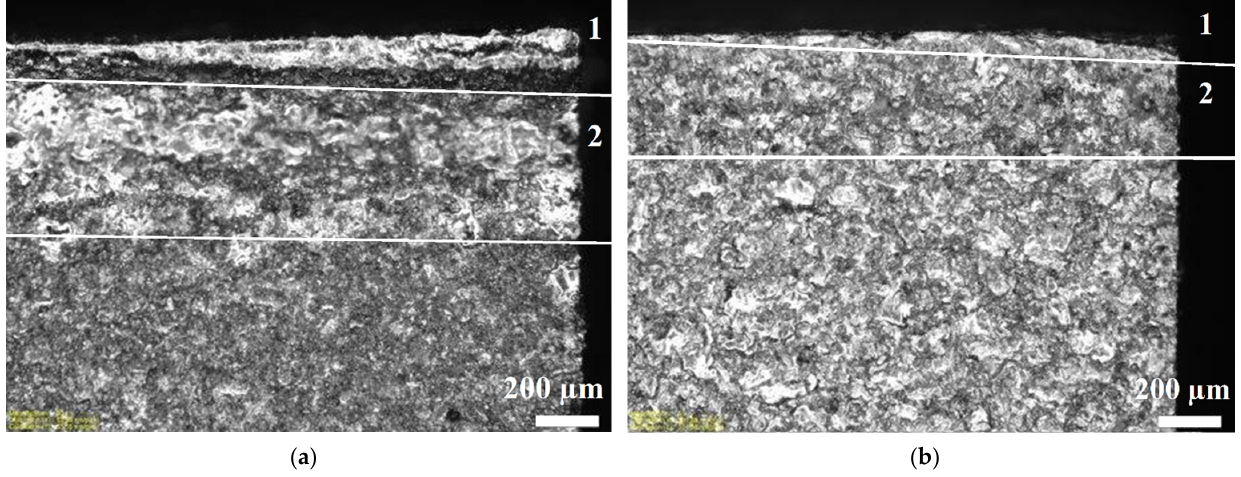
Figure 6. Microphotographs of the workpiece surfaces after electrical discharge machining with a brass wire tool electrode in a water medium at the end of the operation: ( a ) X10CrNiTi18-10 (12kH18N10T) steel, V o = 60 V; F t = 30 N; ( b ) 2024 (D16) duralumin, V o = 60 V; F t = 35 N, where (1) is mechanical rupture location, (2) is melting traces of the short circuit.